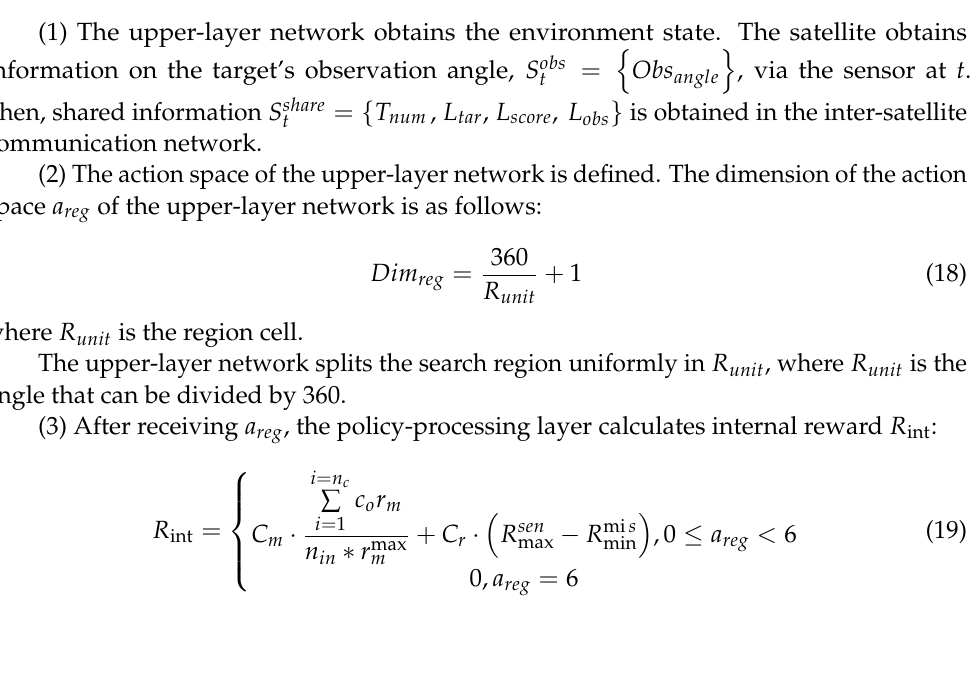
Figure 7. The structure of